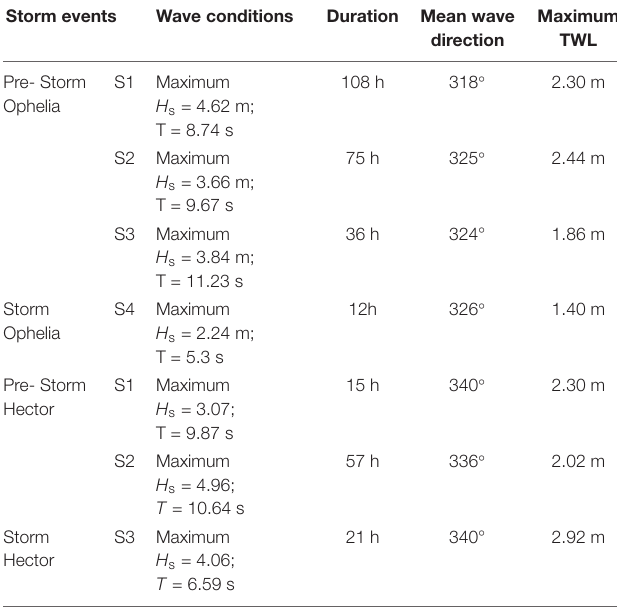
TABLE 2 | Storm characteristics for each surveyed period pre- and post-Ophelia and Hector storms. Storm events Wave conditions Duration Mean wave